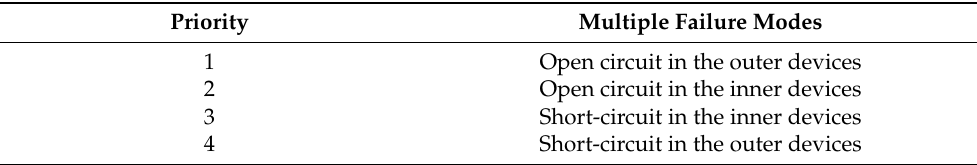
Table 4. Priority list for multiple failure modes inside each phase. Priority Multiple Failure Modes Open circuit in the outer devices Short-circuit in the inner devices 4 Short-circuit in the outer